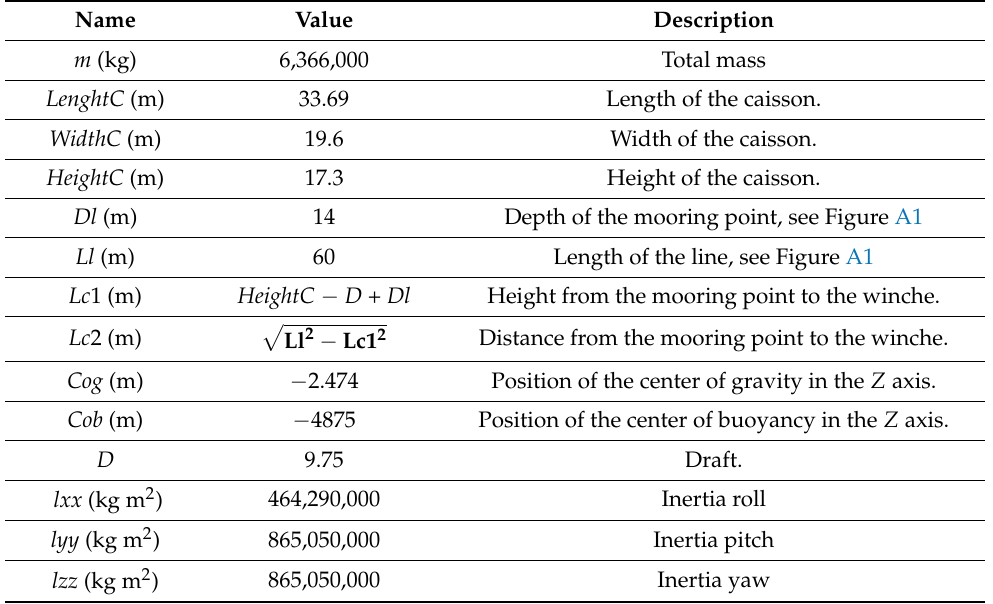
Table A1. Weight distribution of the